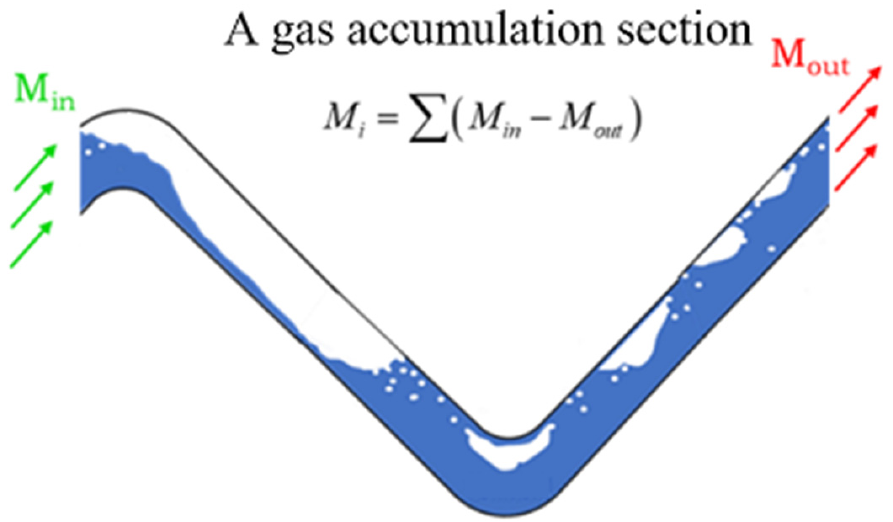
Figure 9. Mass change diagram of a single gas accumulation unit.